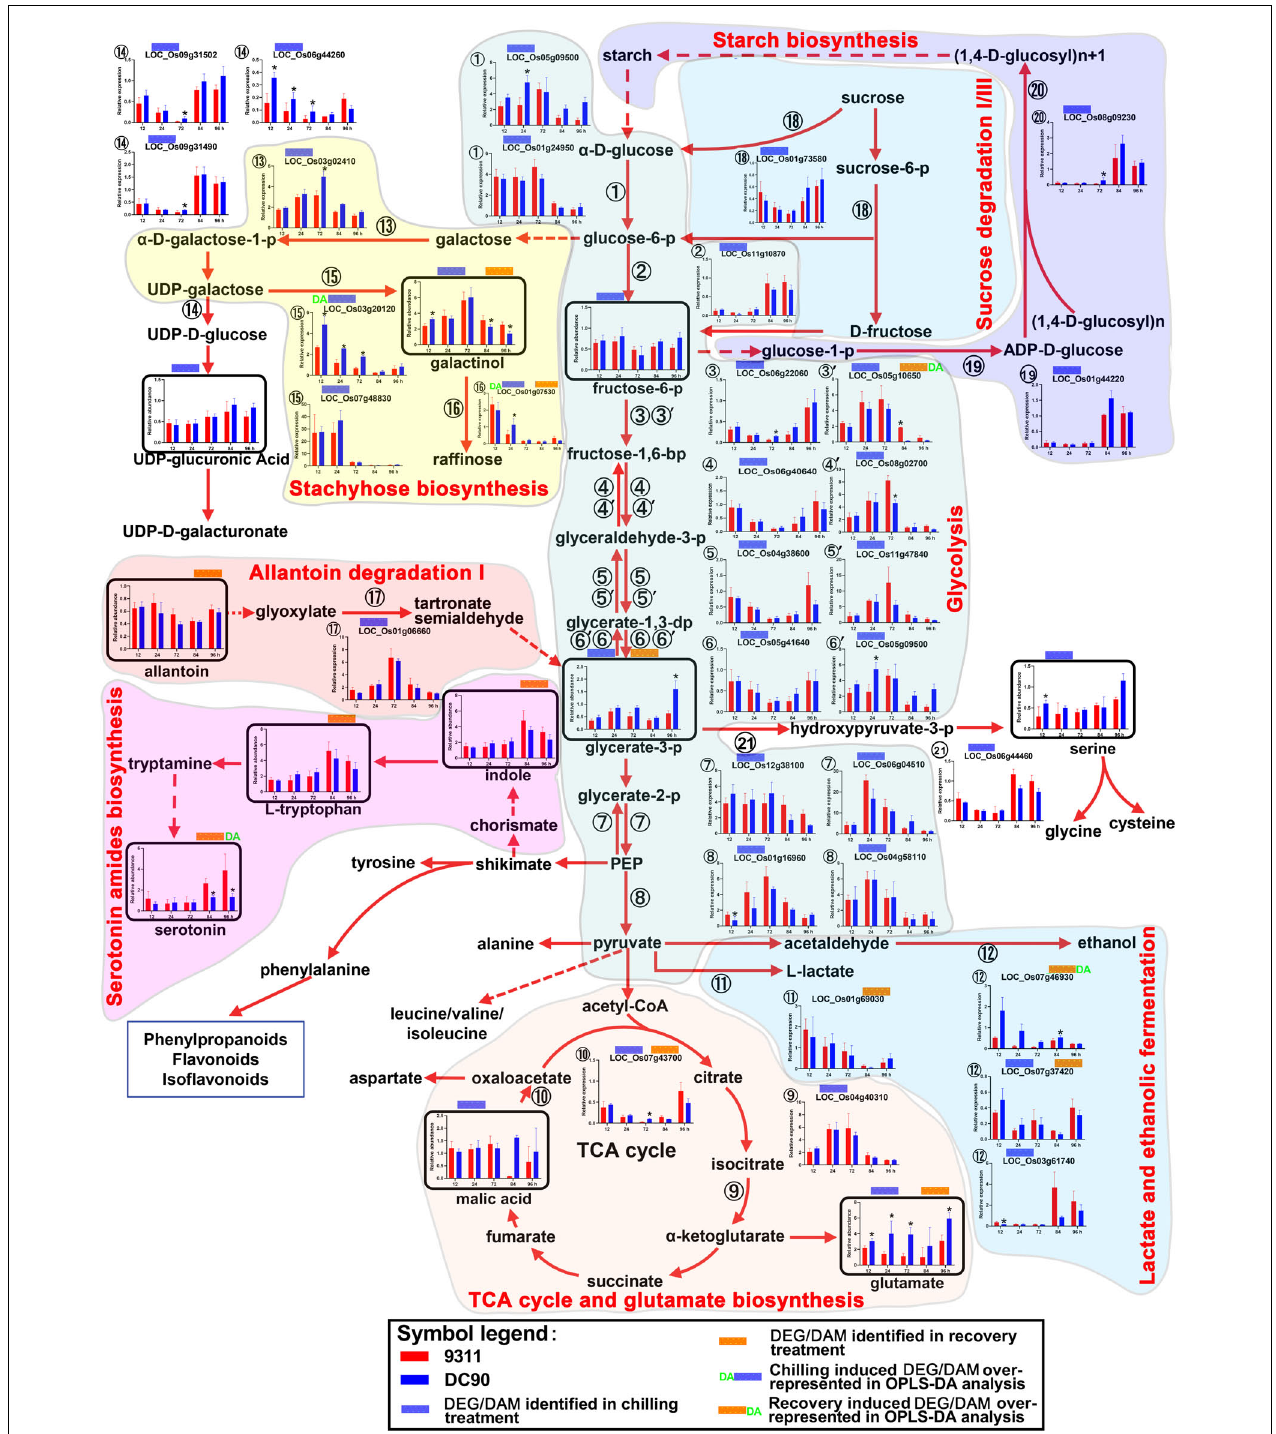
FIGURE 3 | Chilling- and/or recovery-induced DEGs and DAMs mapped to carbohydrate metabolism and their related pathways. The boxed bar plots represent the metabolites with relative abundance alterations at certain timepoints in response to chilling (blue bar at the top) or recovery (orange bar at the top) treatment. The relative expression level alteration plots of genes encoding related enzymes are numbered accordingly for the space limitation. The blue and orange bars at the top of the plot represent the transcripts or metabolites that were significantly altered in response to chilling (blue bar) and/or recovery (orange bar) treatment. The plot of transcripts or metabolites with green letters DA to the left of the blue bar or to the right of the orange bar represent transcript or metabolite members of discriminatory DEGs/DAMs that play key roles in differentiating the chilling tolerance capacity of 9311 and DC90. The red and dashed arrows represent overall upstream/downstream relationships and the conversion catalyzed by multiple steps in the related pathways, respectively. *Significant at P ≤ 0.05 level according to Student’s t test.